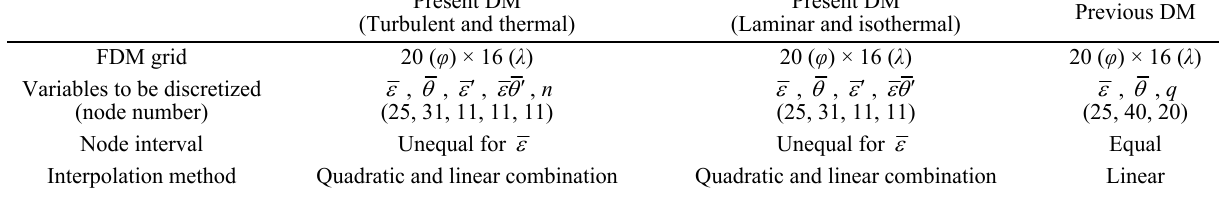
Present DM (Turbulent and thermal)